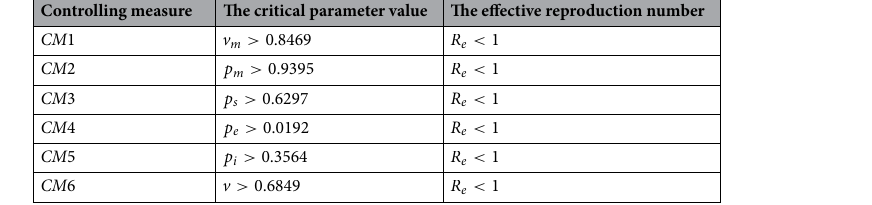
Table 8. The threshold condition for the effective reproduction number R e < 1 .